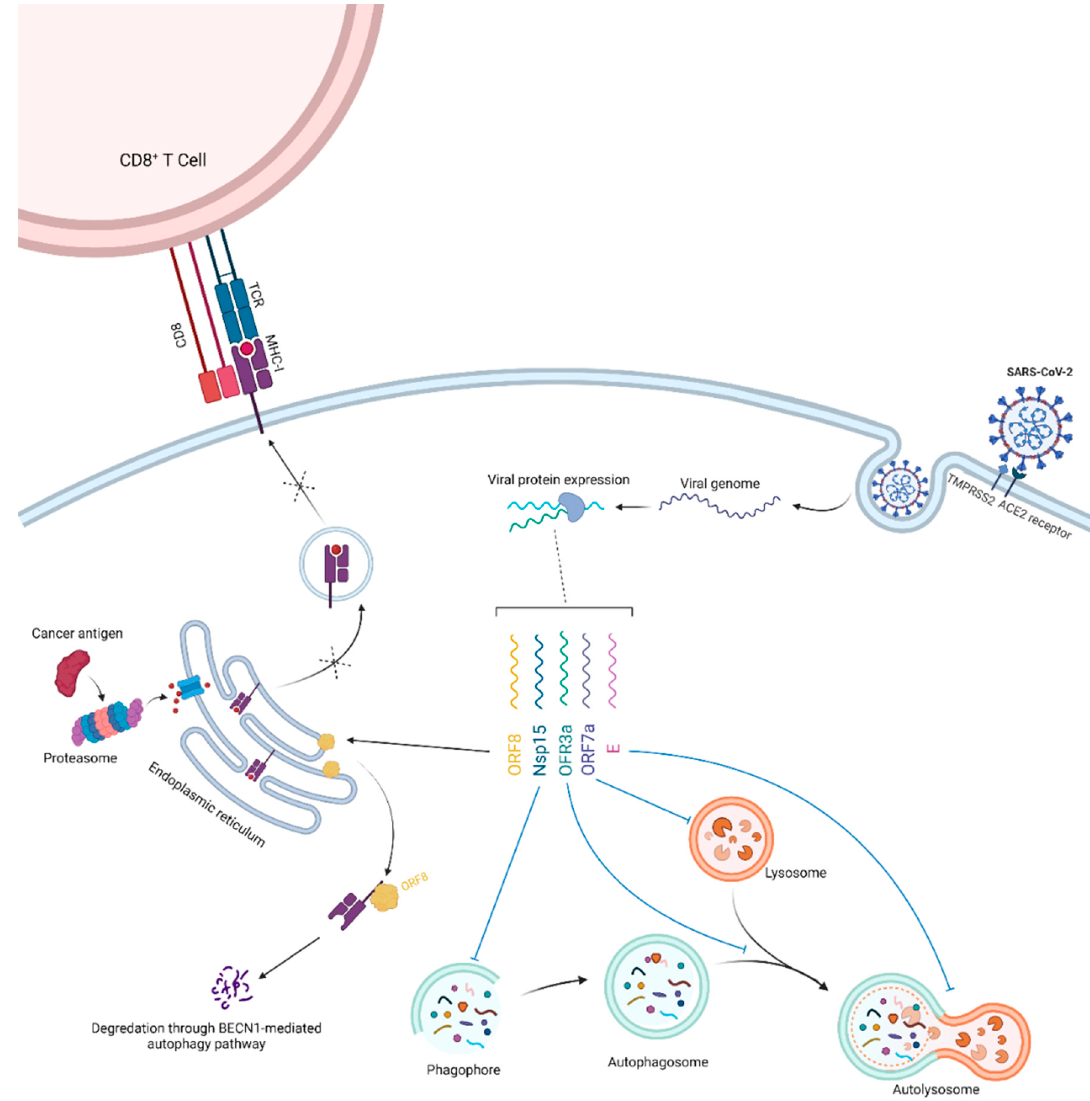
Figure 2. SARS-CoV-2 infects enterocytes through ACE2 receptors and TMPRSS2 expressed on their surface. The release of the viral genome and production of viral proteins (simplified in this schema) will lead to the interaction of various SARS-CoV-2 antigens with the host cell autophagy machinery. Overall, this will induce the blockage of the autophagic flux. The accumulation of reactive oxygen species, damaged cellular proteins and organelles, and acquired genetic defects due to various stressors can lead to the development of malignancies. Furthermore, infection can also interfere with the cellular MHC-I antigen-presentation pathway, blunting the ability of host cytotoxic CD8 + T cells to recognize potential oncogenic antigens.